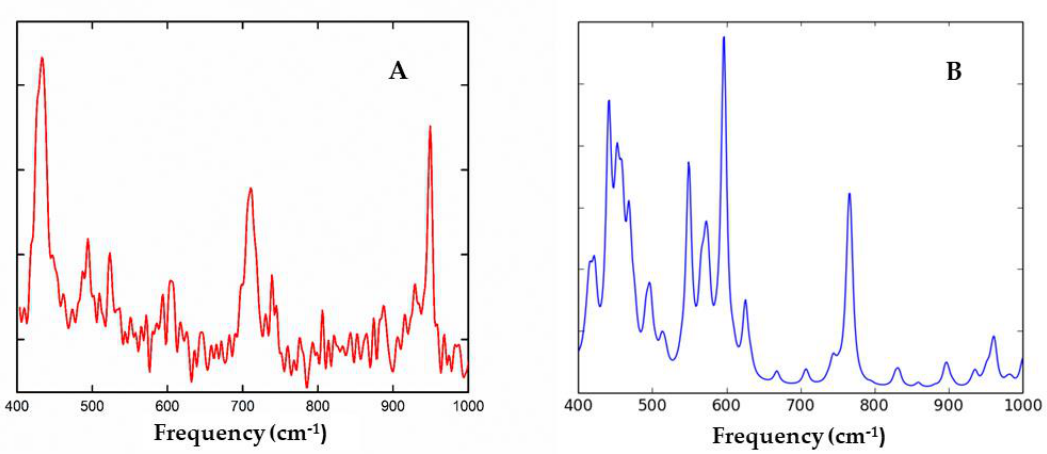
Figure 11. Experimental ( A ) and theoretical Raman spectrum ( B ) of Compound 1 calculated at the M06-2X / Def2TZVP-LANL2TZ(f) level of theory using the ECP = LANL2TZ(f) for V and Cu in the CPCM model and water solvent.